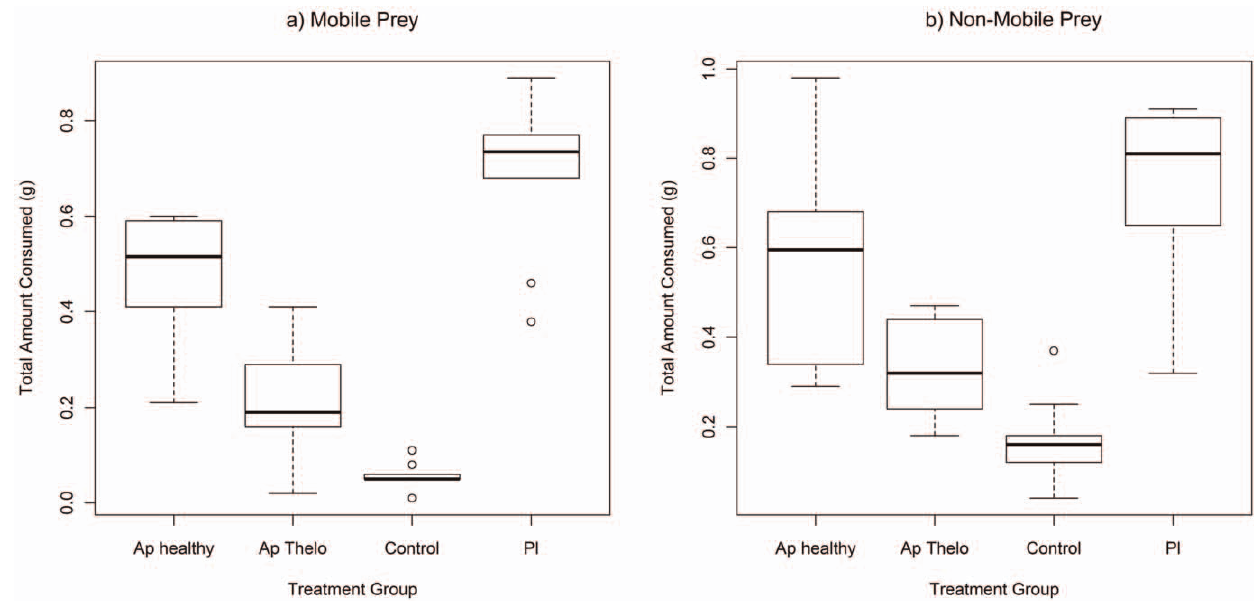
Figure 1. Total food consumption for crayfish. a) mobile and b) non-mobile food items for P.leniusculus (Pl), healthy A.pallipes (Ap healthy), A.pallipes with T.contejeani (Ap Thelo), and controls. Plots show medians (thick line), interquartile ranges (boxes) and data range (whiskers), with outliers as open circles.